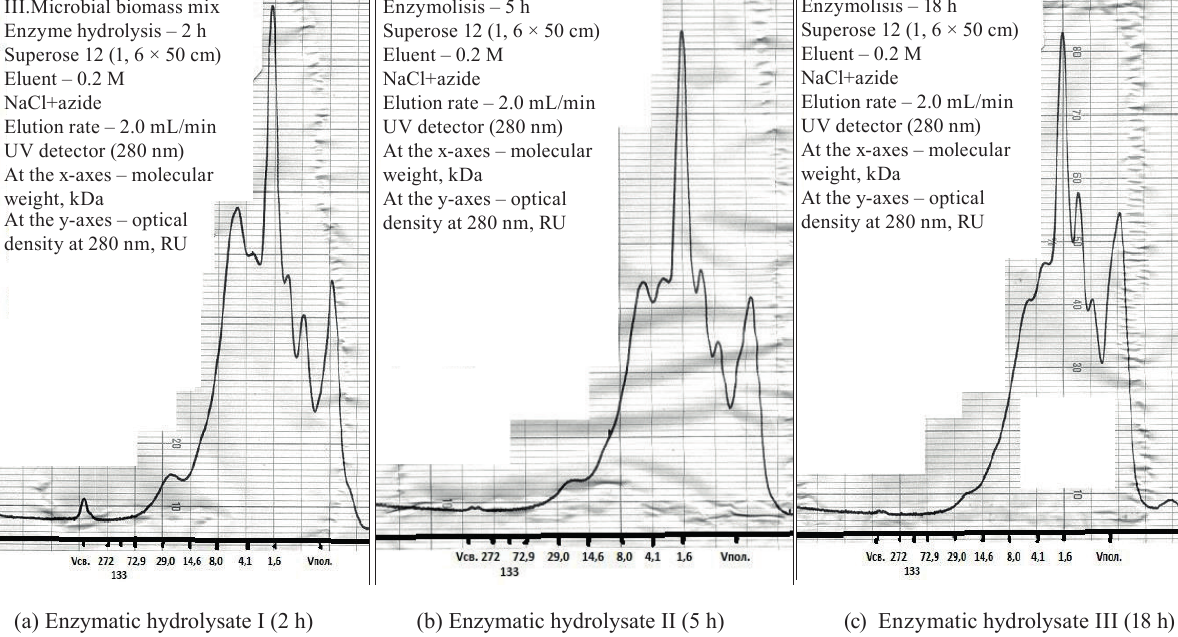
Figure 4 Molecular weight distribution of bioconversion products of protein polymers in the enzymatic hydrolysates of the microbial biomass mix ( Aspergillus oryzae and Sаcharomyces cerevisiae )